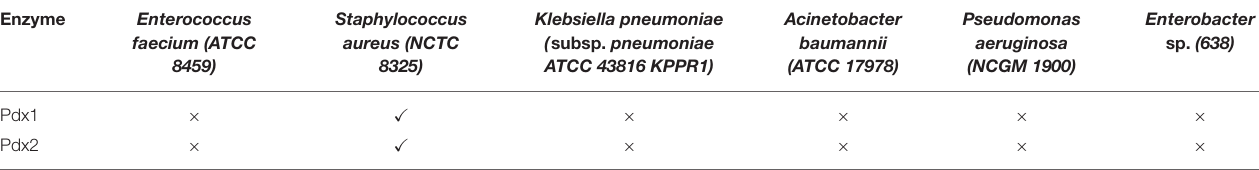
TABLE 2 | Panel of observed enzymes for the pyridoxal 5 ′ -phosphate pathway in ESKAPE pathogens.